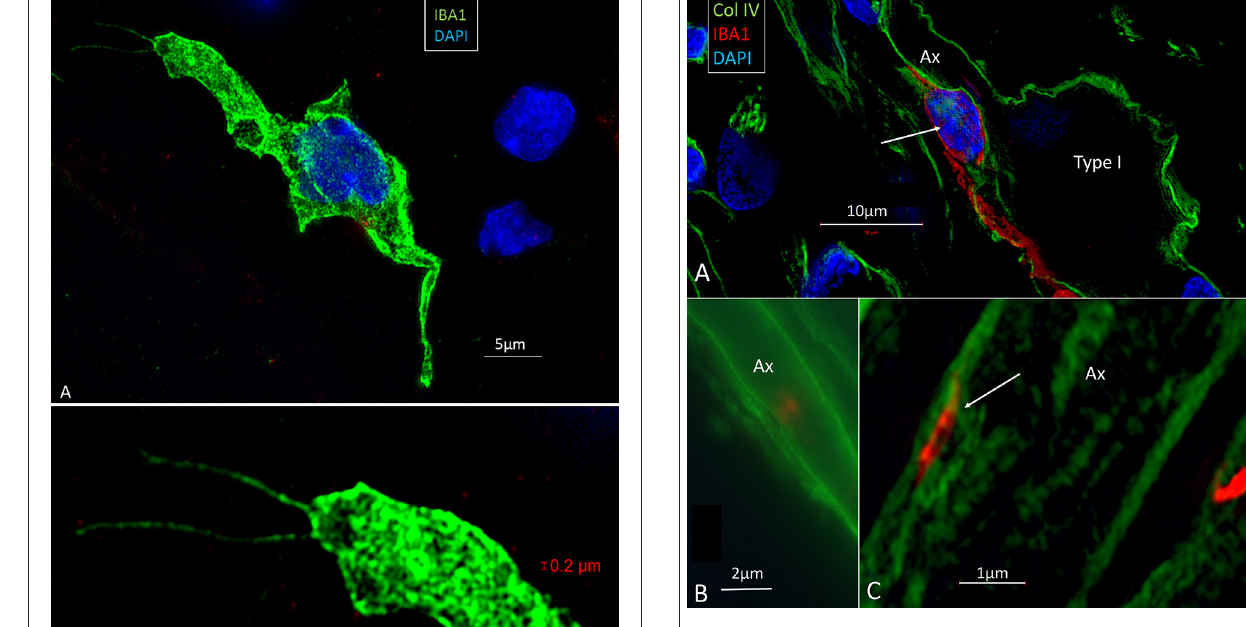
(PRRs) that recognize injury (32, 33) and toll-like receptors (TLRs) that spot infection (34). TLR signaling induces second-